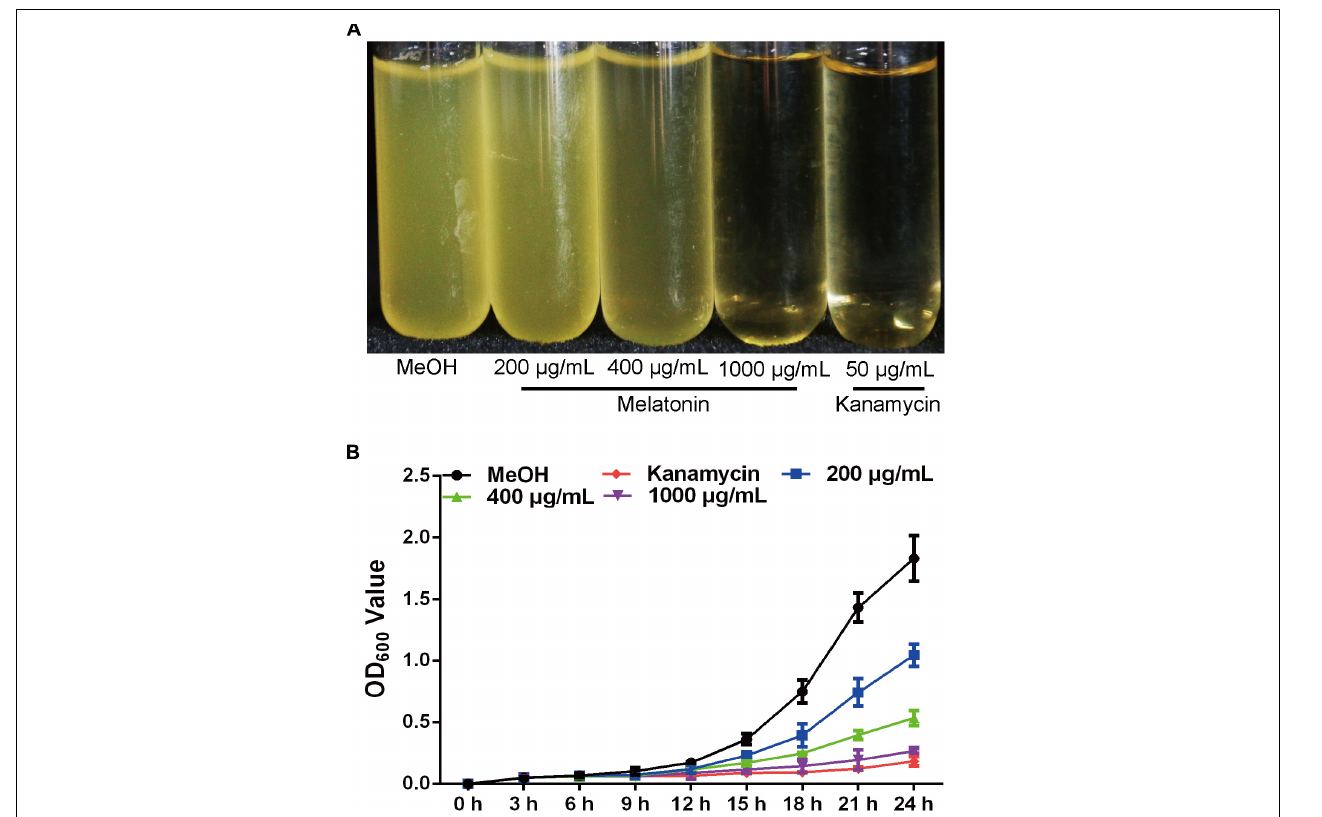
FIGURE 1 | Melatonin inhibits the growth of Xoo . (A) The state of PXO99 under melatonin treatment. (B) Statistical analysis of growth curves of PXO99 treated with different concentrations of melatonin ( µ g/mL) and cultured for 24 h.